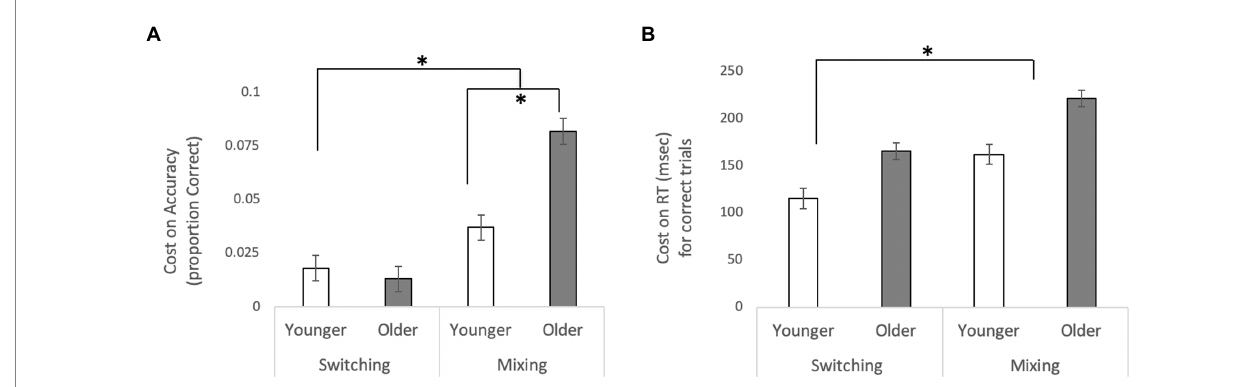
FIGURE 2 Switching and Mixing Costs for (A) accuracy and (B) reaction time for correct trials. For accuracy, switching costs were calculated as the difference between Dual No Switch Trials and Dual Switch Trials, and mixing costs were calculated as the difference between Dual No Switch Trials and Single- task Trials. For RT, cost was calculated in the reverse (switching costs were calculated as the difference between Dual Switch Trials and Dual No Switch Trials, and mixing costs were calculated as the difference between Single-task Trials and Dual No Switch Trials). In both cases, a higher value indicates a greater cost. Error bars are standard error of the mean. * p